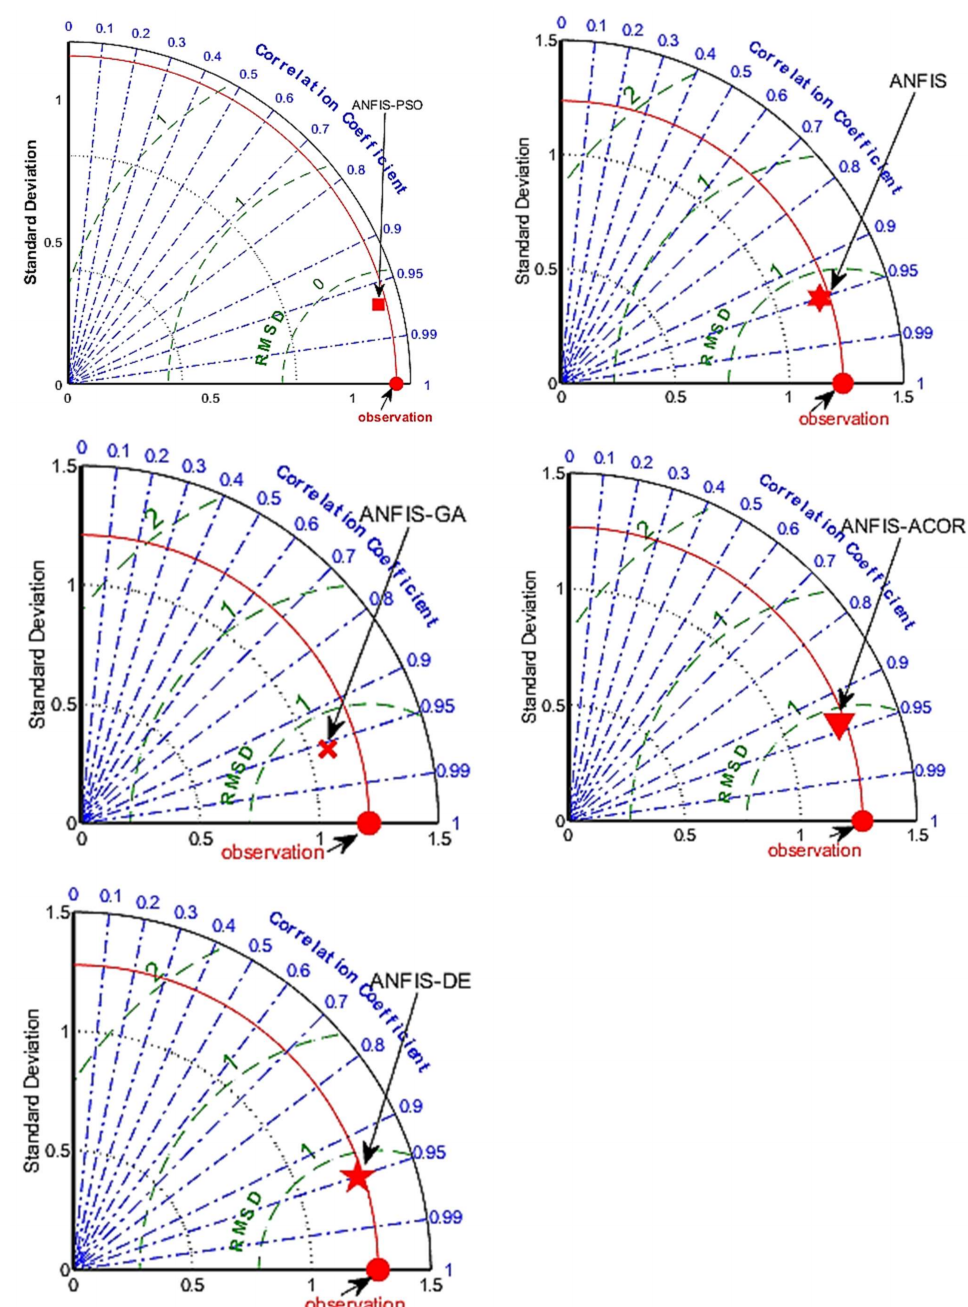
Figure 7. Taylor’s diagram for the selected input pattern of each model for the observation well